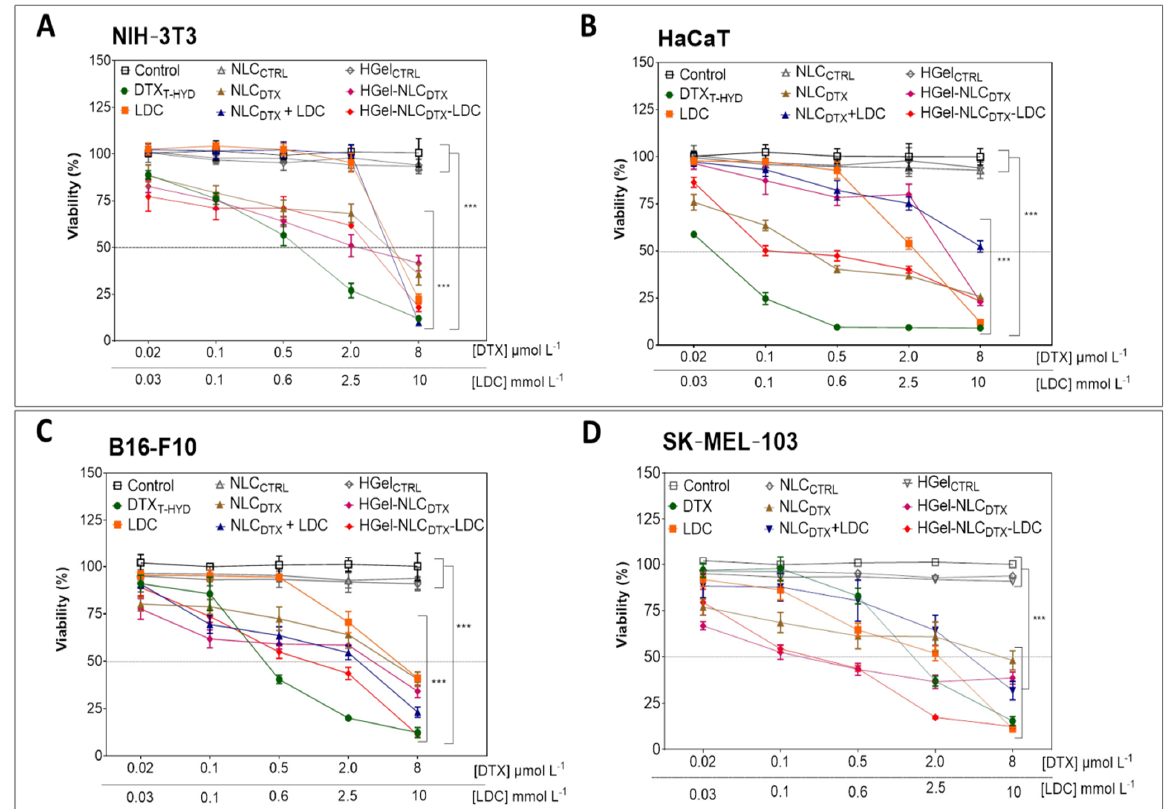
Figure 2. Viability of NIH-3T3 ( A ), HaCaT ( B ), B16-F10 ( C ) and SK-MEL-103 ( D ) cells after 24 h of treatment with DTX T-HYD , LDC, NLC DTX , NLC DTX + LDC, HGel-NLC DTX or HGel-NLC DTX -LDC at 0.02, 0.1, 0.5, 2 and 8 µ mol L − 1 (equivalent DTX concentrations) and 0.03, 0.1, 0.6, 2.5 and 10 mmol L − 1 (equivalent LD concentrations, evaluated by MTT assay. In the